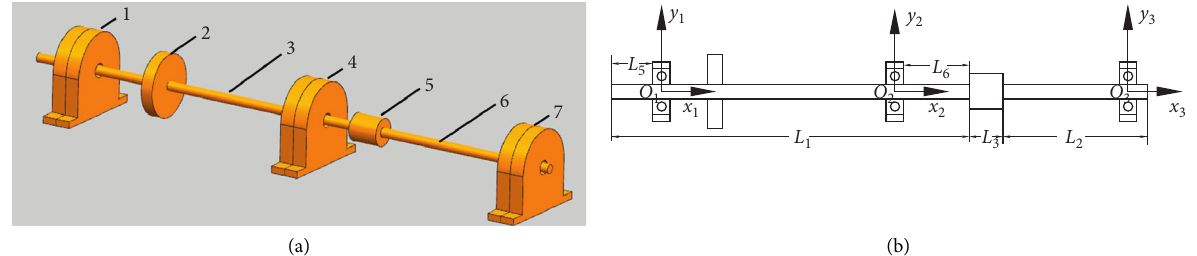
Figure 1: Schematic of the flexible rotor shafting system. 1-support I; 2-turntable; 3-shaft I; 4-support II; 5-coupling; 6-shaft II; 7-support III. Table 1: Three-bearing rotor shafting reference parameters. Parameter